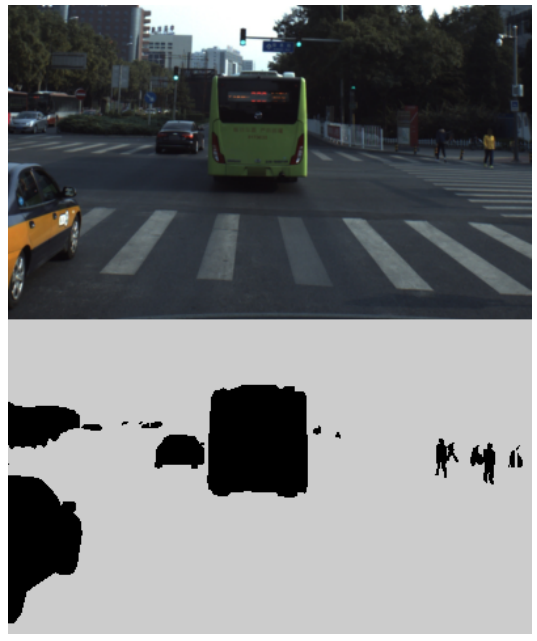
Figure 1. Top image is an example frame acquired from a camera mounted on a vehicle showing the road scene from vehicle’s perspective. The bottom image is a background reference with pixel-wise labels; gray part indicates background and black part indicates